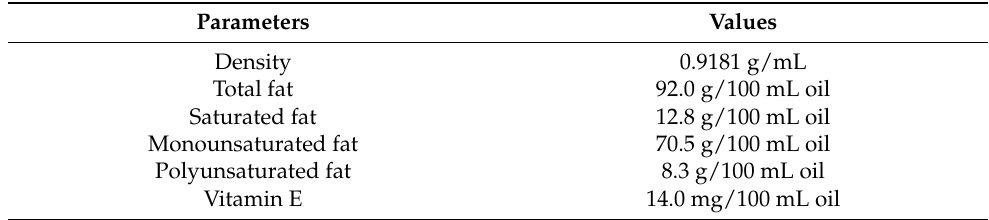
Table 2. The physicochemical parameters of olive oil.